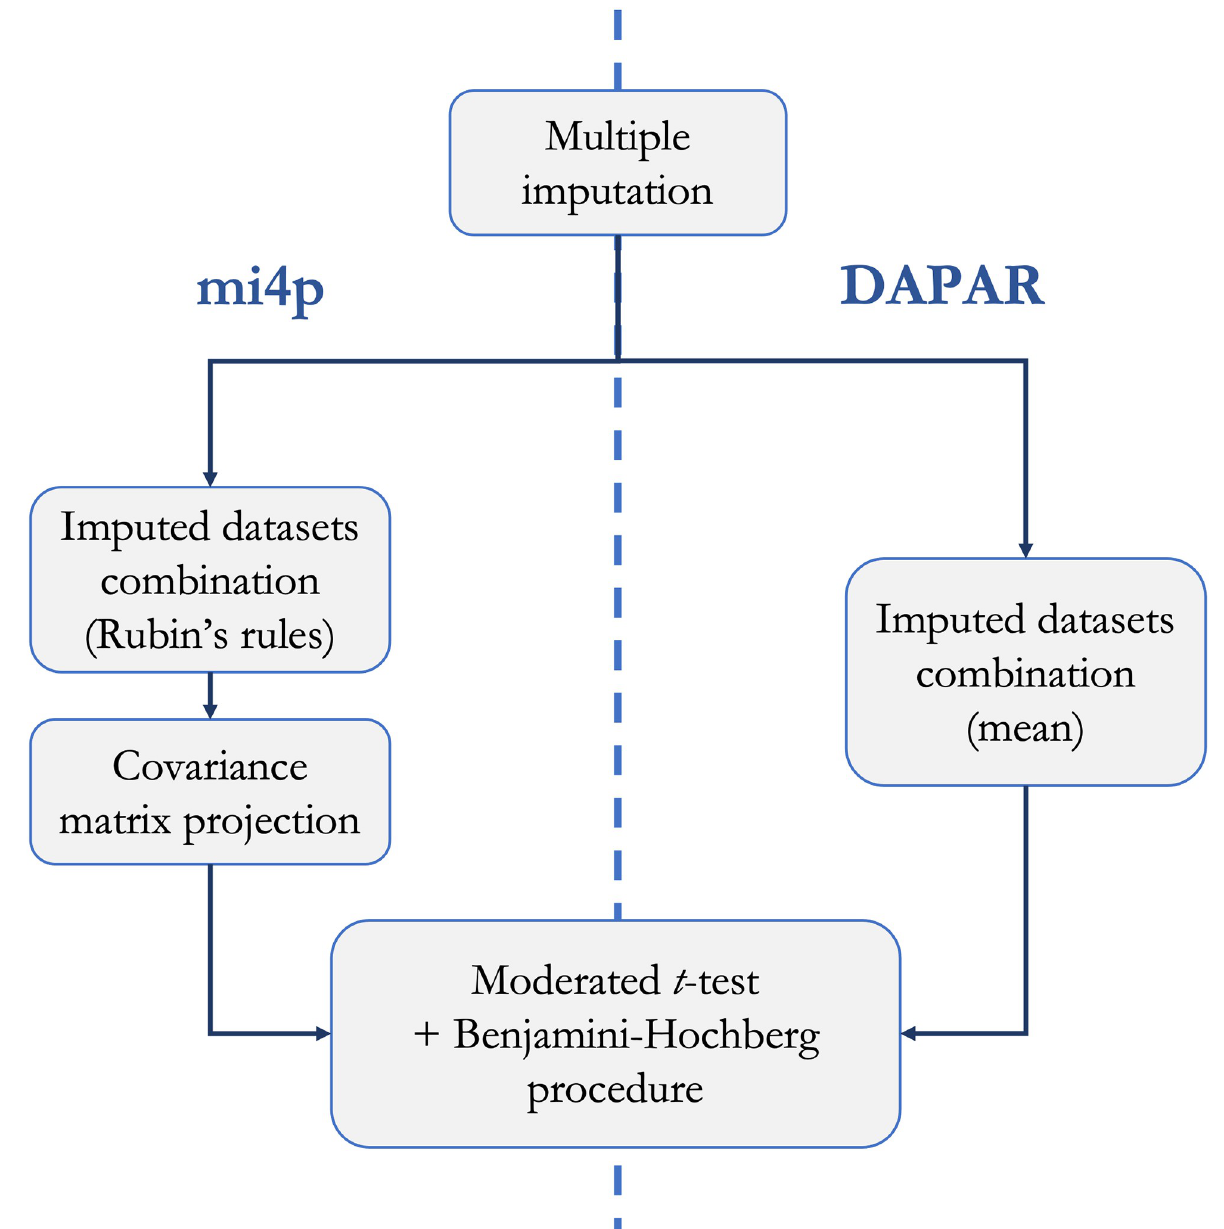
Fig 3. Workflow conducted for performance evaluation of the mi4p methodology and comparison to the one implemented in the DAPAR R package.